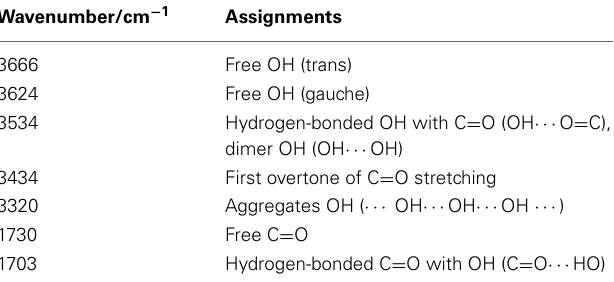
Table 1 | Assignments of selected IR absorption bands in PHEMA.